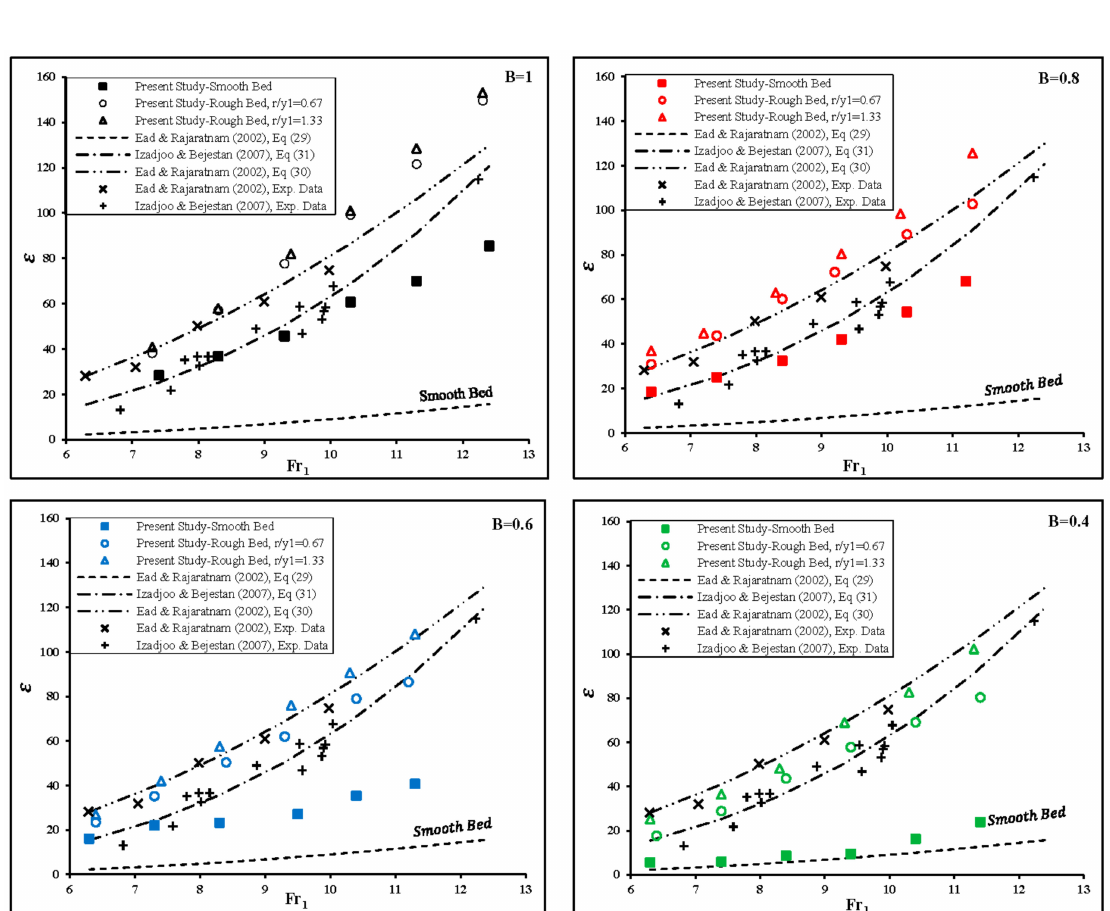
Figure 17. Variation of the shear force coefficient ( ε ) vs. the inflow Froude number for different divergence ratio ( B = 1, 0.8, 0.6 and 0.4) and two relative heights of dissipative elements ( r / y 1 = 0.67 and